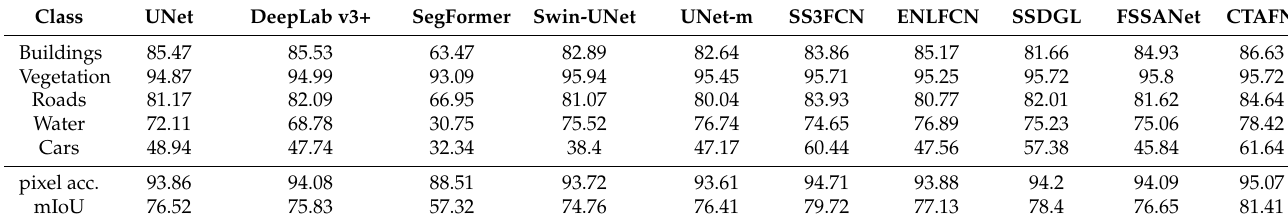
Figure 7. Visually comparison of different methods on the AeroRIT test set. Table 5. Classification results for the AeroRIT test